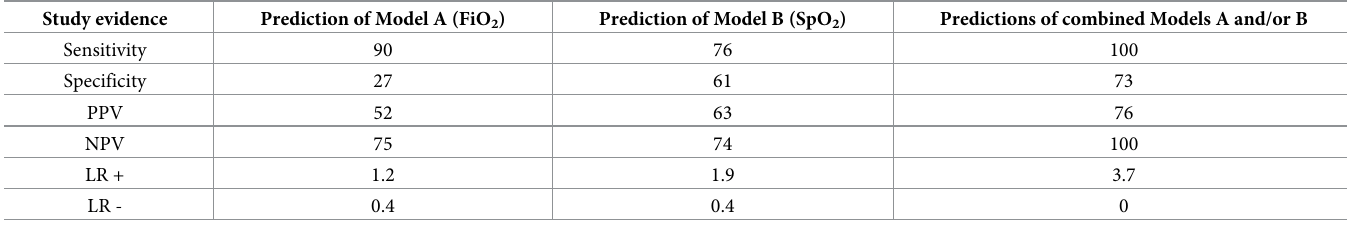
Table 6. External validity of Type 1 ROP based on the ROP risk scoring model.